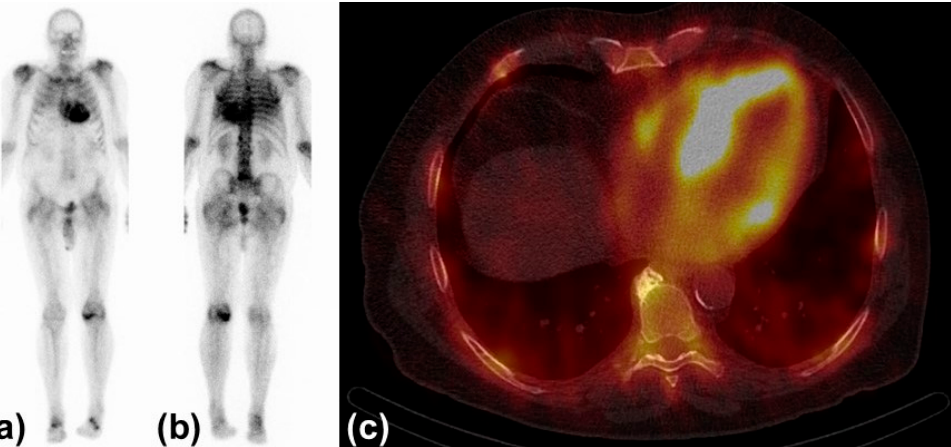
Figure 3. Typical findings in scintigraphy and single-photon emission computed tomography: ( a ) Anterior view of 99Tc-hydroxymethylene diphosphonate scintigraphy with myocardial uptake Perugini Grade 3. ( b ) Posterior view of the same study. ( c ) Left and right ventricular uptake of 99mTc-hydroxymethylene diphosphonate in single-photon emission computed